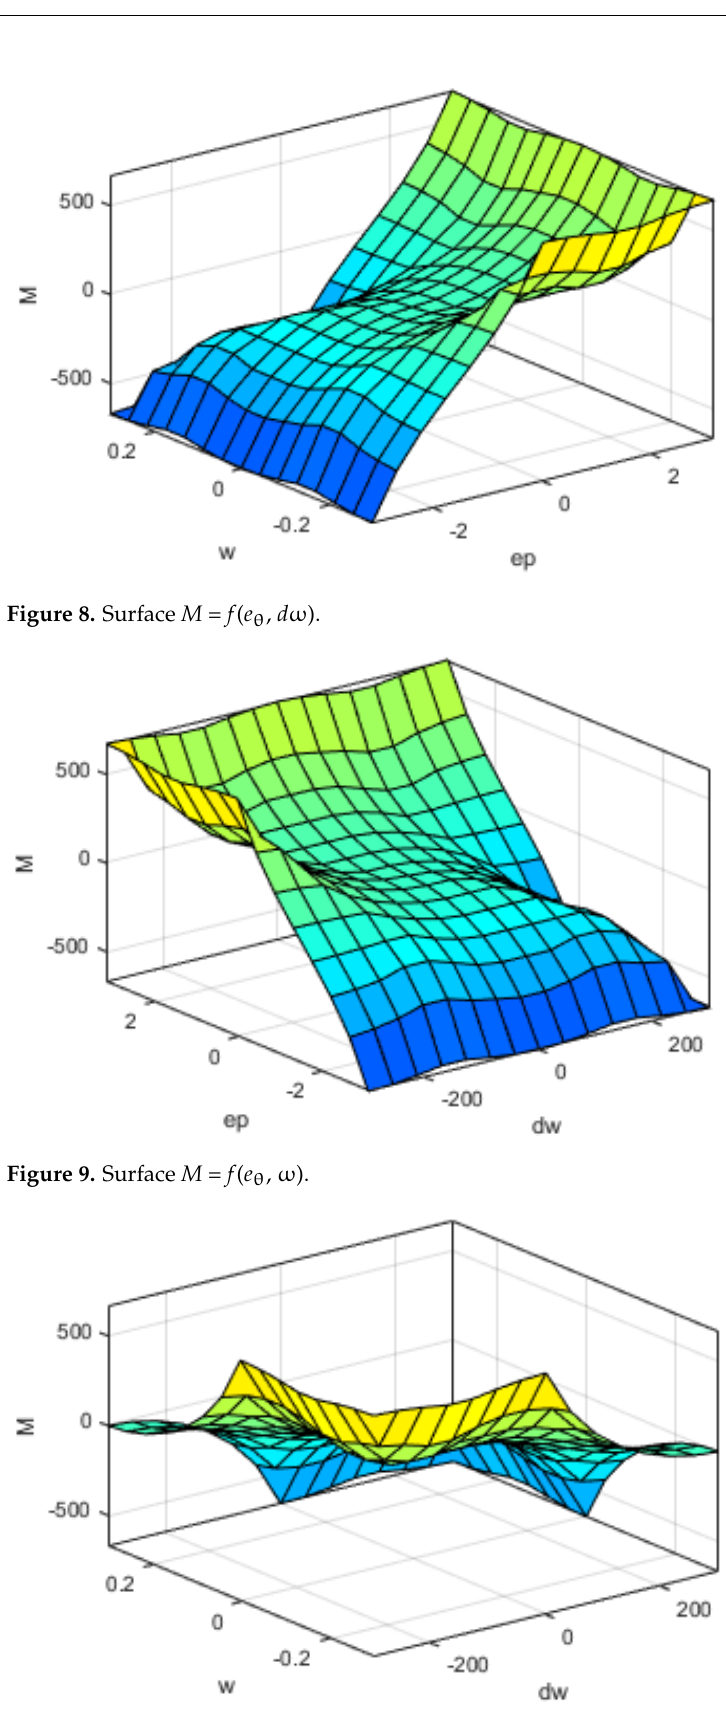
Figure 10. Surface M = f ( d ω , ω ).